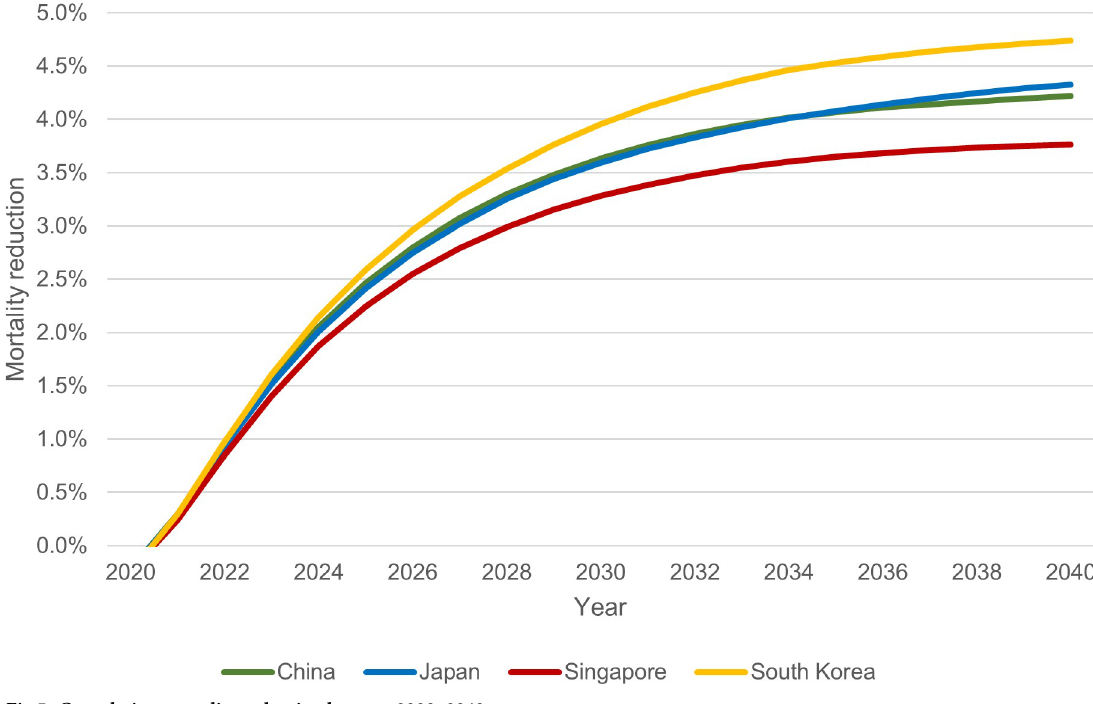
Fig 5. Cumulative mortality reduction by year,